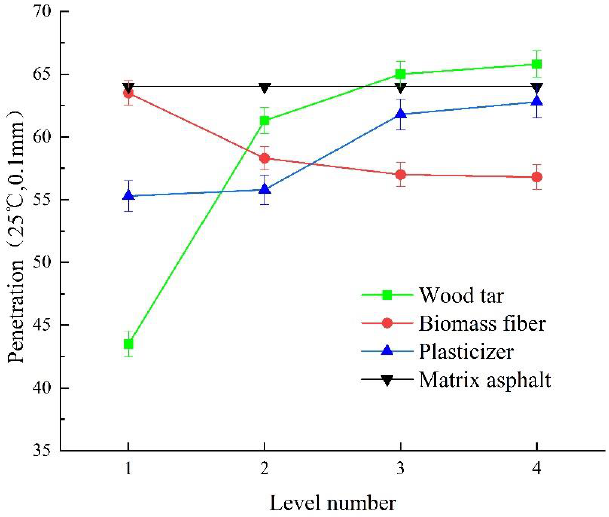
Figure 5. Change rule of penetration of wood tar-based rejuvenated asphalt under different factors and levels.